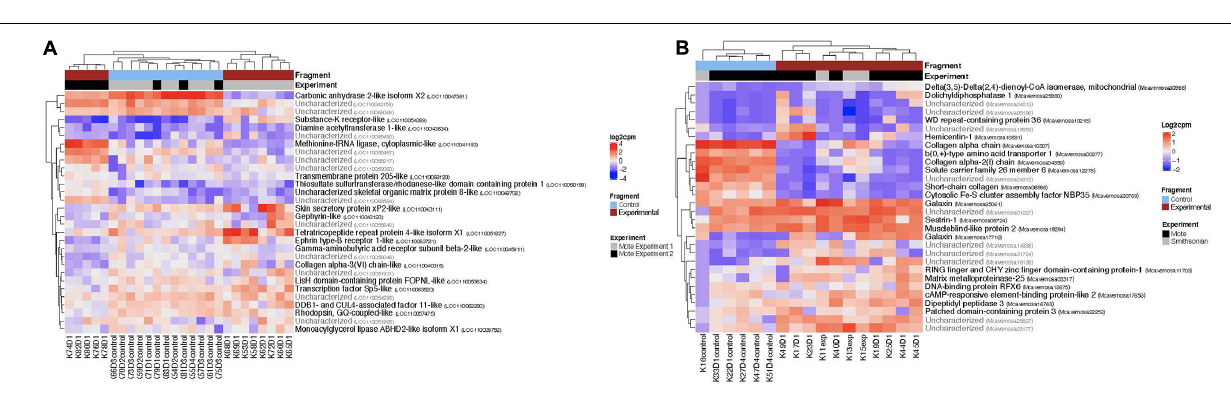
FIGURE 4 | Normalized counts of top expressed genes in both O. faveolata and M. cavernosa . Counts were normalized by log2 transformation of counts per million. Two distinct clusters separate control fragments (left cluster) from experimental fragments (right cluster), regardless of experiment. The top 30 differentially expressed genes had FDR p adj < 6.5 × 10e - 5 . (A) Heatmap of log2 counts per million for O. faveolata top 30 differentially expressed genes. Gene counts for 26 samples (13 control, 13 experimental) are shown. Red represents experimental samples, blue indicates control. Gray represents experiment 1 and black represents experiment 2, of the two separate transmission experiments were run at Mote Marine Laboratory. Three distinct clusters separate gene expression patterns of all control fragments (center cluster), experiment 1 disease exposed fragments (far right cluster), and experiment 2 disease exposed fragments (far left cluster). Top 30 differentially expressed genes had FDR p < 6.5 × 10e - 11 . (B) Heatmap of log2 counts per million for M. cavernosa top 30 differentially expressed genes. Gene counts for 17 samples (6 control, 11 experimental) are shown. Red represents experimental samples, blue indicates control. Gray represents experiment run at Mote Marine Laboratory; black represents transmission experiment run at the Smithsonian Marine